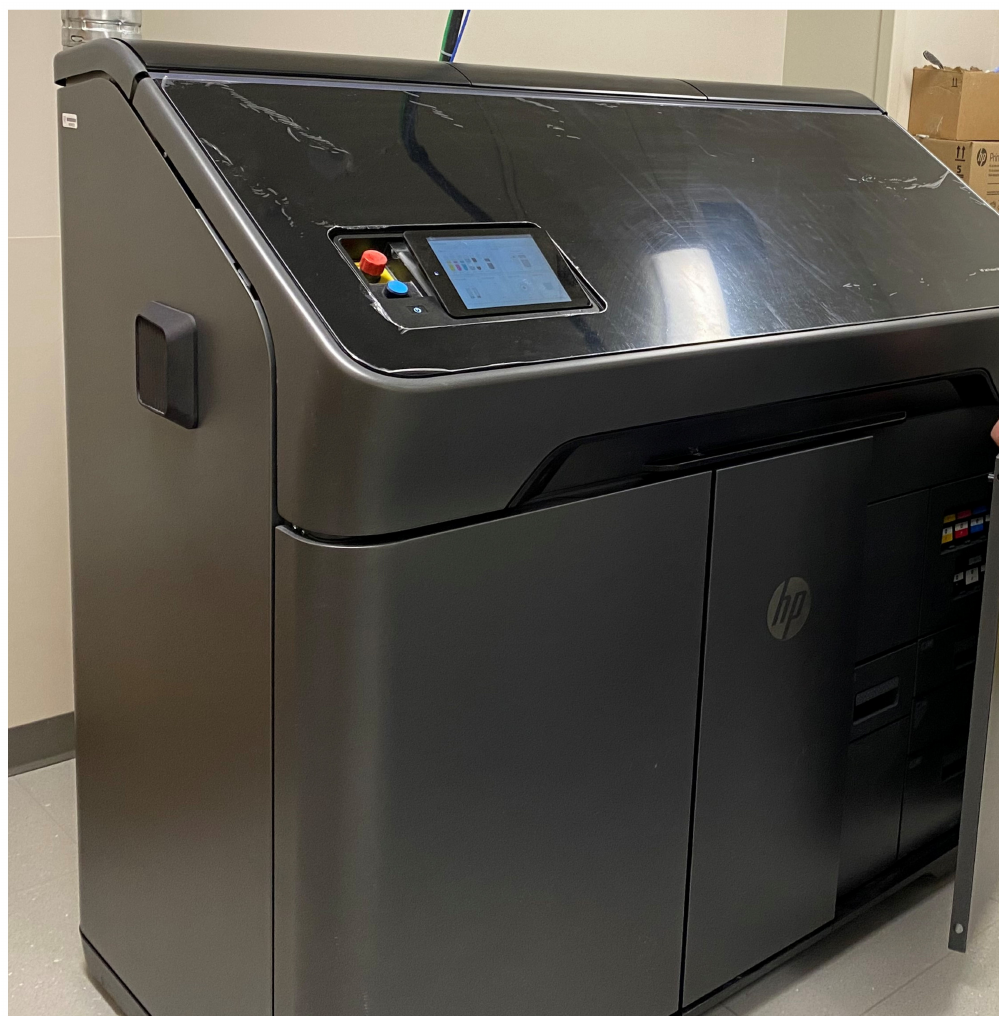
Figure 1. Hewlett-Packard (HP, Palo Alto, CA, USA) 3D